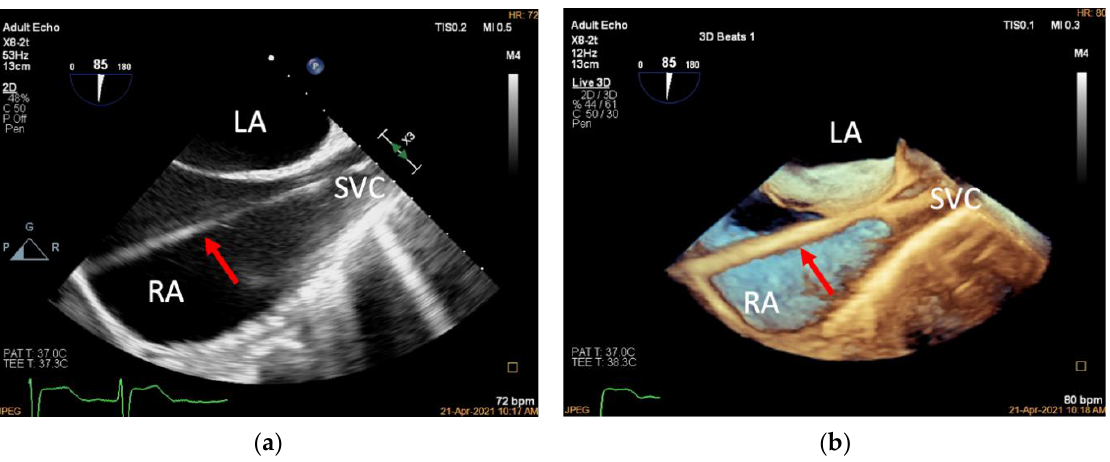
Figure 3. Introducing the guidewire. ( a ): Mid-esophageal bicaval view (transducer angle at 70 – 110°), 2D TEE guiding the Super Stiff guidewire through the superior vena cava to the inferior vena cava (red arrow); ( b ): 3D TEE of the same view. LA, left atrium; RA, right atrium; SVC, superior vena cava.